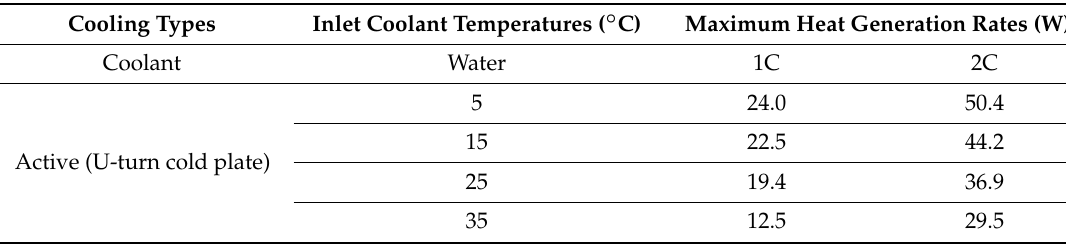
Table 4. Experimental results for the maximum heat generation rate at 1C, 2C discharge rates and the different boundary conditions